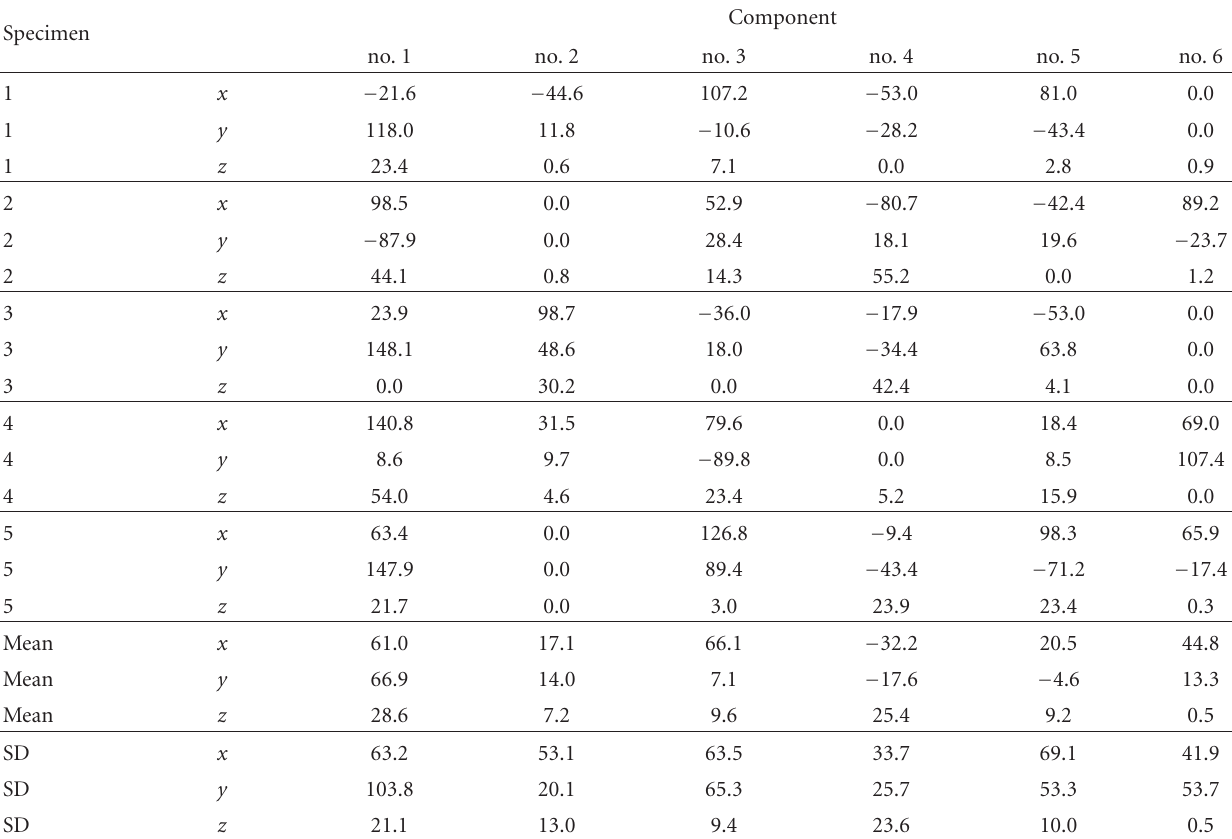
Table 4: The cast [test-master] best-fit di ff erences of each component centroid in µ m.